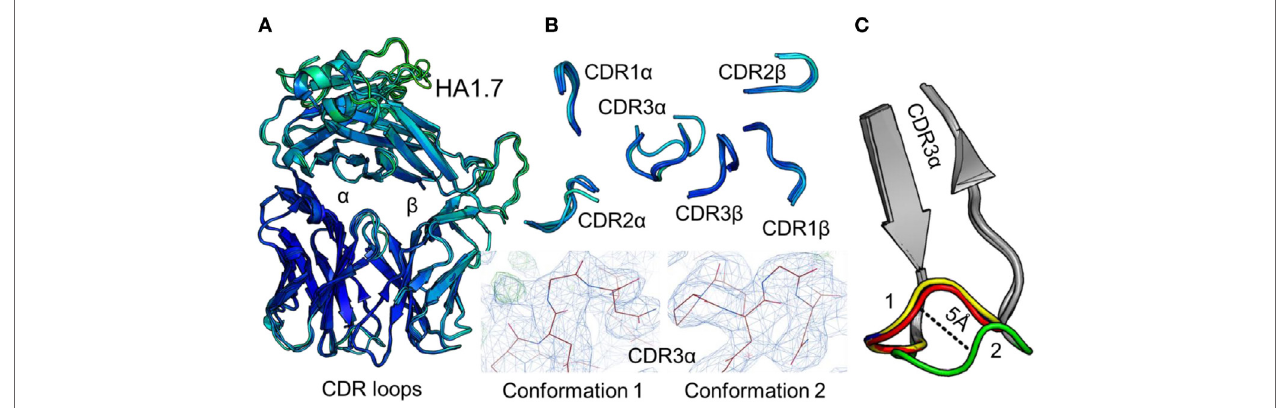
FigUre 2 | Comparison of five unbound structures of the HA1.7 T cell receptor (TCR). (a) Side-on view of the overall conformation of the HA1.7 TCR (cartoon, colored by B-factor) including alignment of structures generated from five different crystals. (b) Top down view of an alignment of the complementarity determining region (CDR) loops (cartoon, colored by B-factor) from the five structures of unbound HA1.7 TCR. The panels below demonstrate the two extreme conformations (conformation 1 and 2) of the CDR3 α loop from the different structures, with the observed electron density map at 1 σ . (c) Side-on view of the HA1.7 TCR CDR3 α loop (framework region in gray, apex of the loop in multiple colors) aligning all five structures with conformation 1 and conformation 2